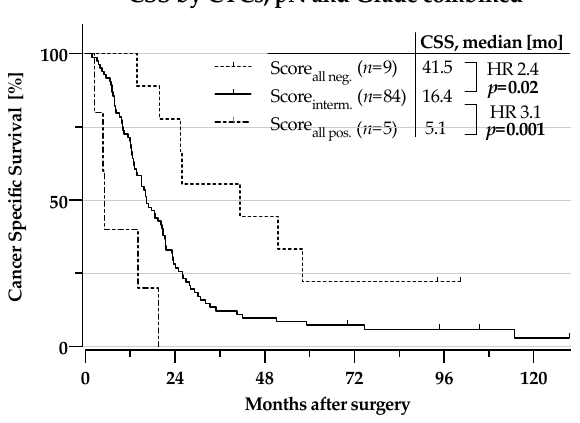
Figure 5. Kaplan-Meier curves for survival times: Cancer specific survival by combination of CTCs, pN1 and Grade > 2 into a score for the entire cohort. Score all neg . : all three negative, Score interm. : one or two factors positive, Score all pos . : all three positive, CSS: cancer-specific survival, CTC: circulating tumour cell, HR: Hazard ratio. Statistical significance assumed for p < 0.05, indicated by use of bold